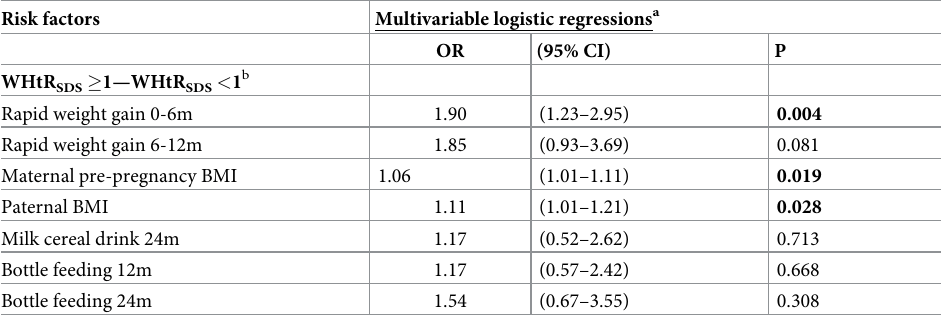
Table 3. Odds ratios and 95% confidence intervals for risk factors for an elevated WHtR SDS in children at five years of